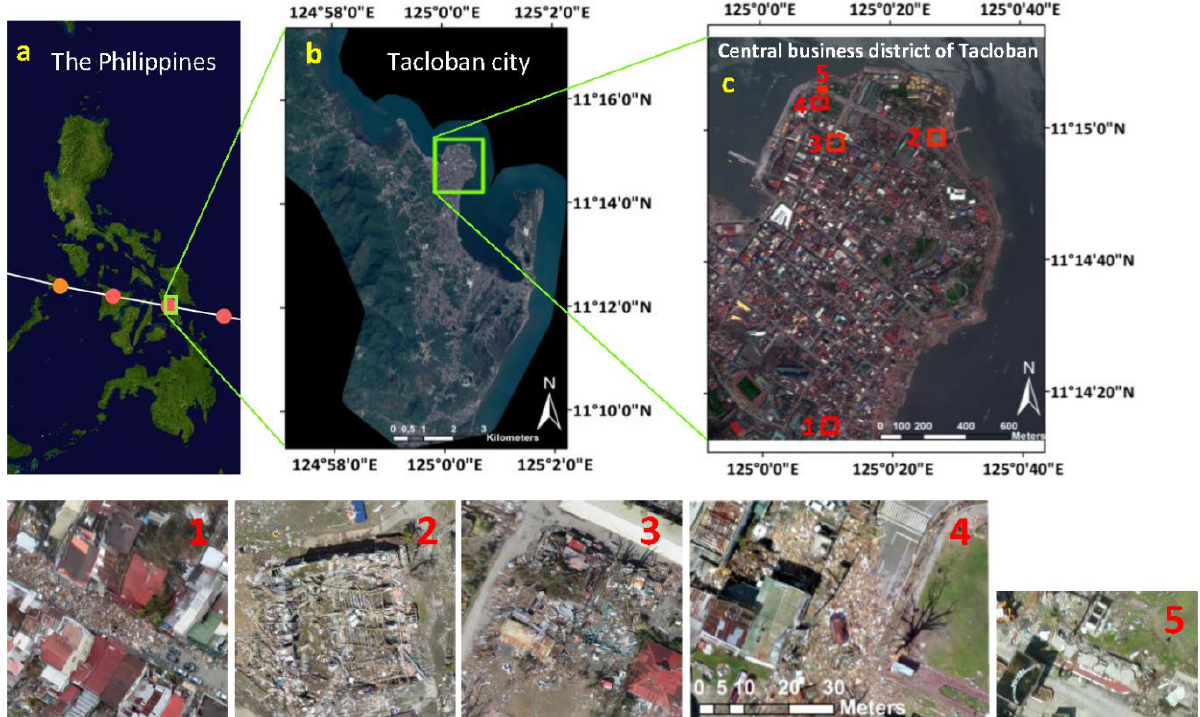
Figure 1. a) Track of Typhoon Haiyan over the Philippines, b-c) Overview of Tacloban city. 1-5) The selected UAV images for one week after disaster from the study